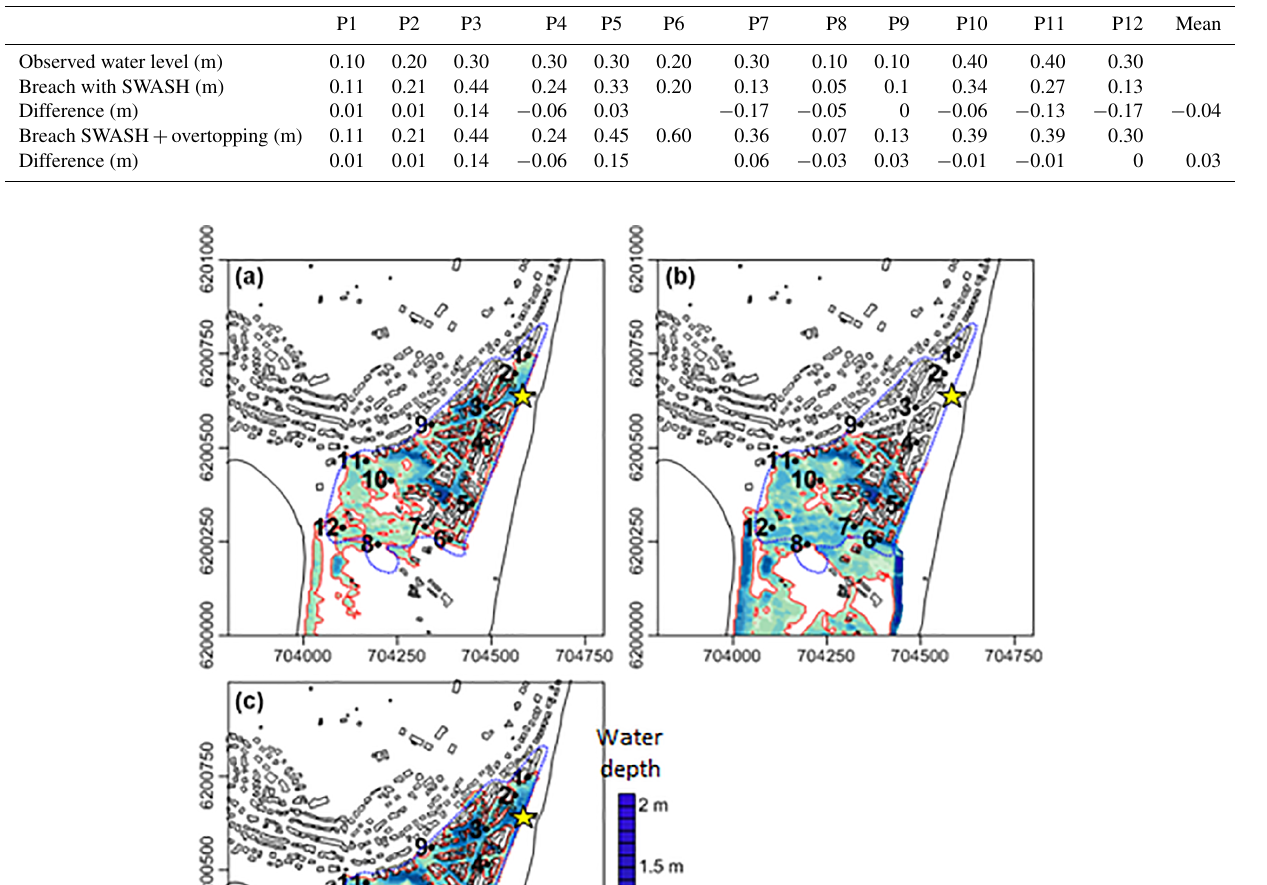
Table 6. Observed vs. simulated water level reproducing flood after breaching.